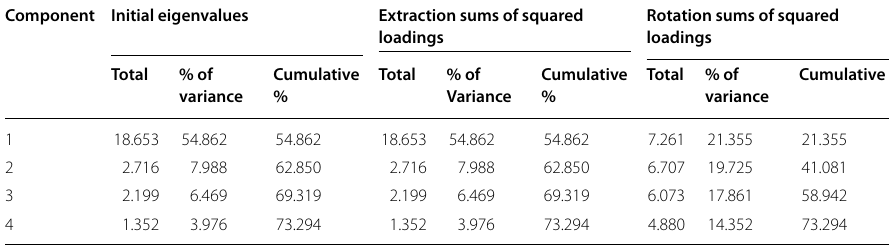
Extraction method: principal component